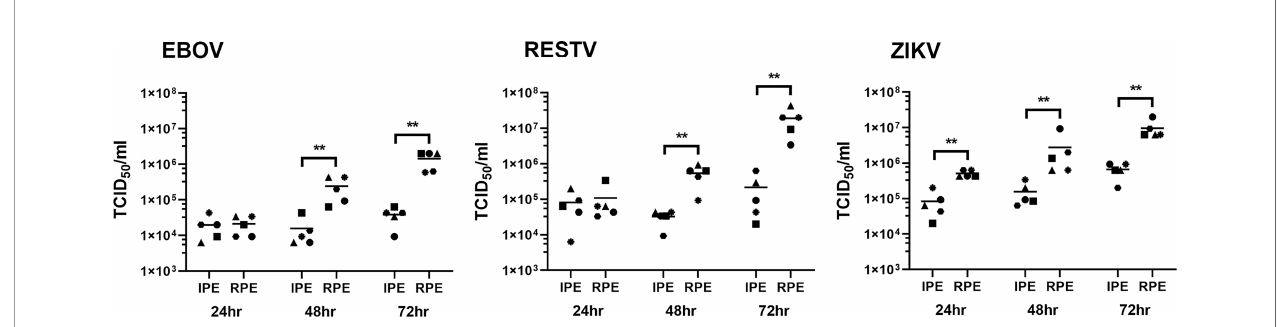
FIGURE 4 | Graphs showing the 50% tissue culture infective dose (TCID50) in culture supernatant collected from EBOV-, RESTV- and ZIKV-infected human iris (IPE) and retinal (RPE) pigment epithelial cell monolayers 24, 48 and 72 hours (hr) following inoculation at a multiplicity of infection of 1 (n = 5 donors/condition). Shapes represent individual cell isolates, and crossbars represent means. Statistical comparisons were made between IPE and RPE by Mann-Whitney U test (** p